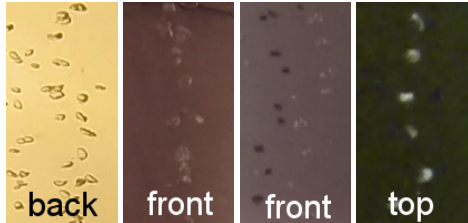
Figure 4. Different lighting configurations. By far the best results are achieved by back lighting, i.e. , using a diffuse light source behind the bubbles. This causes the bubbles to appear as dark contours. When using a diffuse light source from the same direction as the camera, the bubbles are less well distinguishable from the background. Using non-diffuse front lighting causes the bubbles to have shadows, which complicates the detection process. Another interesting option can be top lighting, which can be seen in the right